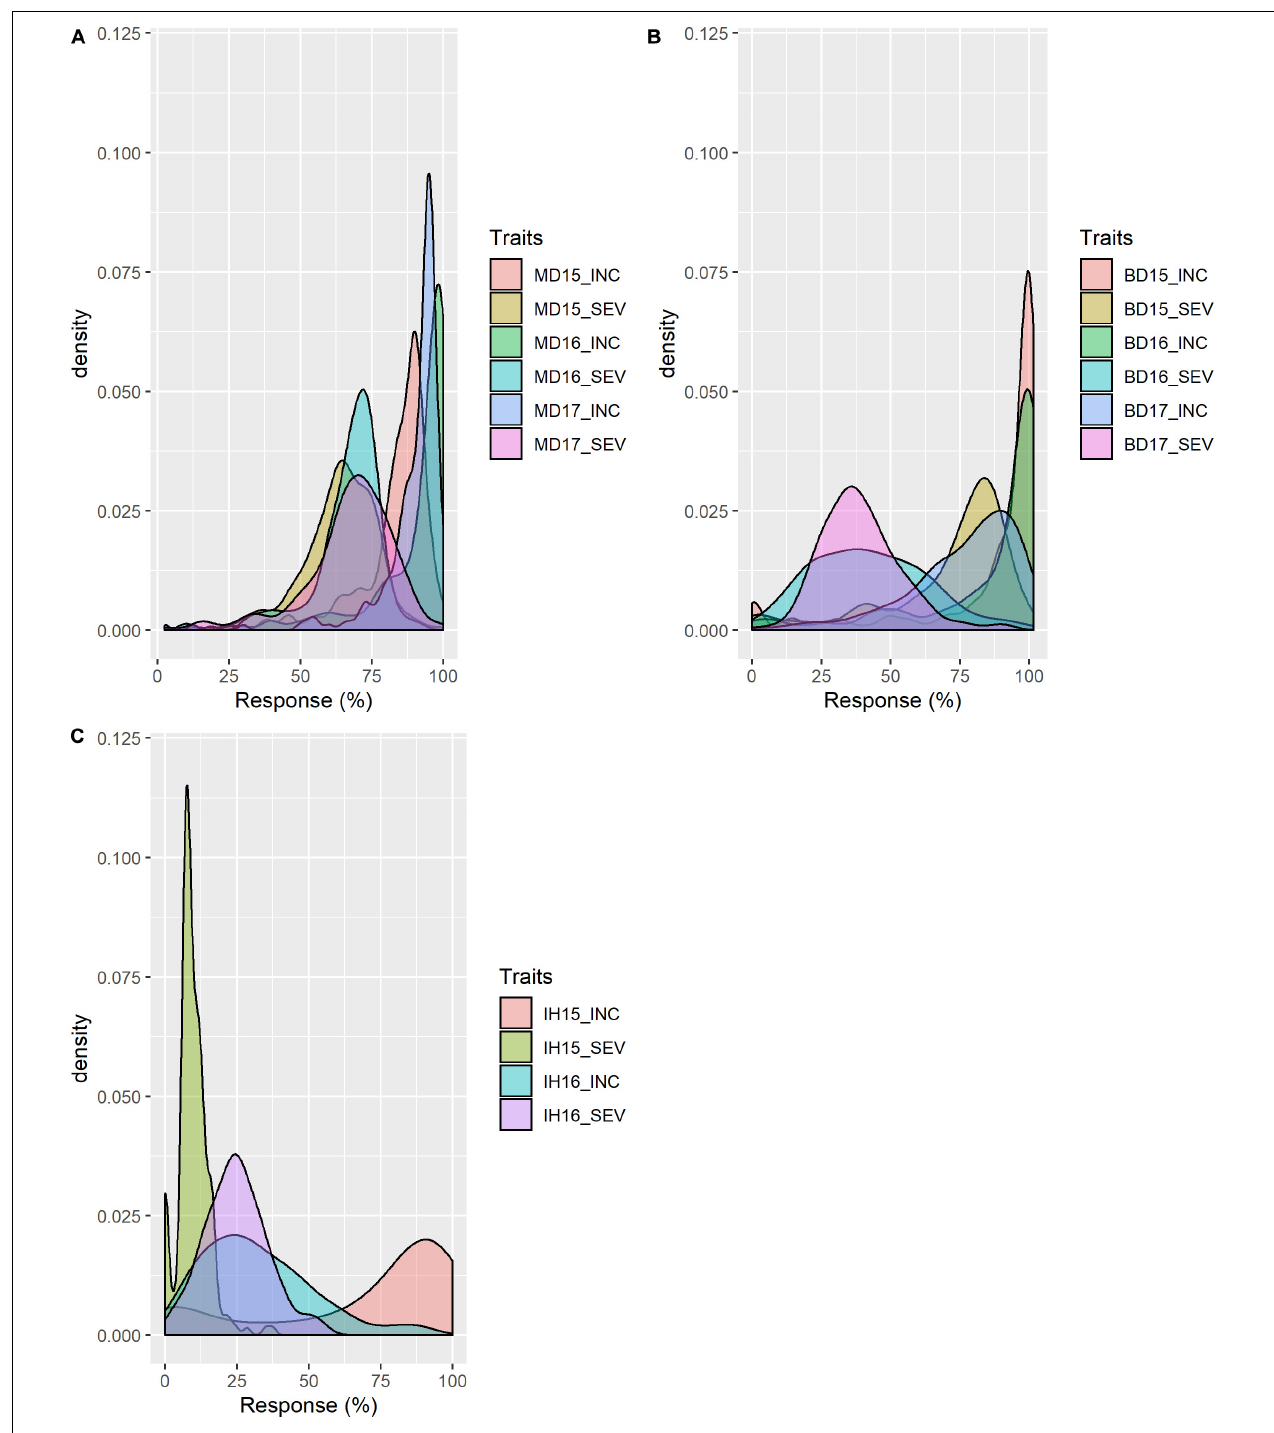
FIGURE 2 | Distribution of FHB resistance of the durum association mapping panel (AM) in field trials at (A) Morden, MB; (B) Brandon, MB; and (C) Indian Head, SK. INC: incidence (%), percentage of spikes showing symptoms; SEV: severity (%), percentage of spike area infected. 15, 16 and 17: years 2015, 2016, and 2017.